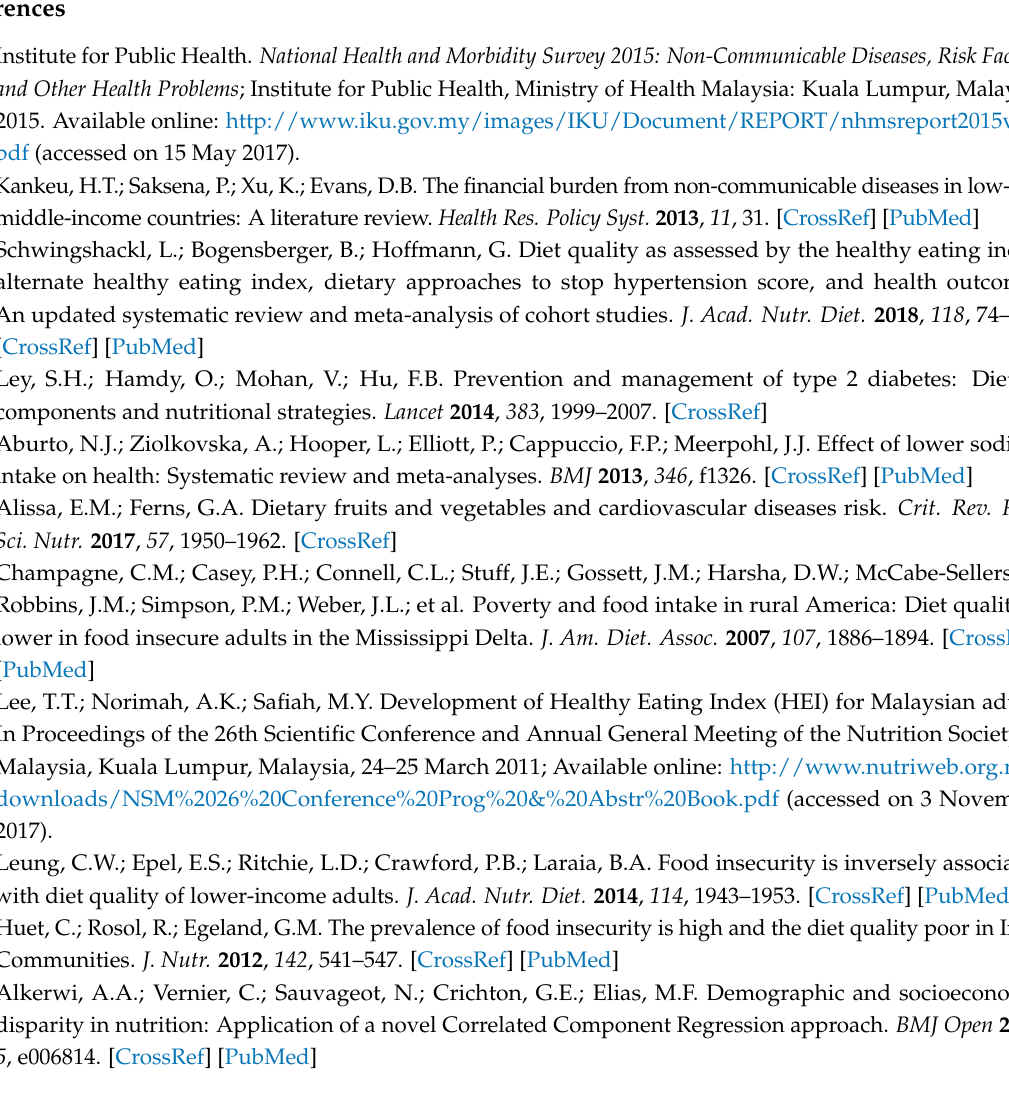
Table S1: Serving size for each food group. Table S2: Recommended serving sizes according to food groups based on total energy intake. Table S3: Relationship between socio-demographic characteristics, nutrition knowledge, food security status, adjusted macronutrients, and diet quality from the simple linear regression